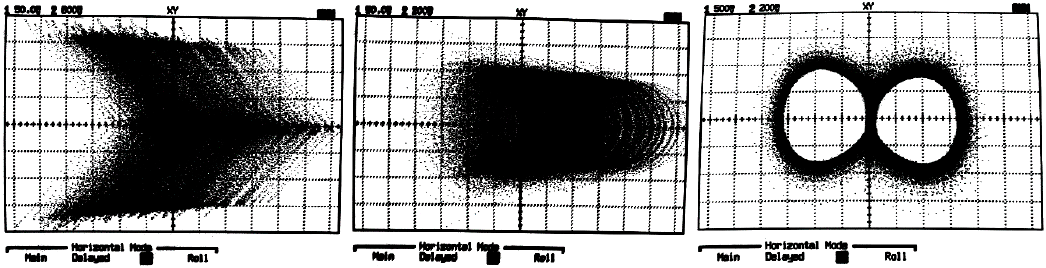
Figure 8. Centered oscilloscope screenshots: xy , xz and yz plane projections of the strange attractor.